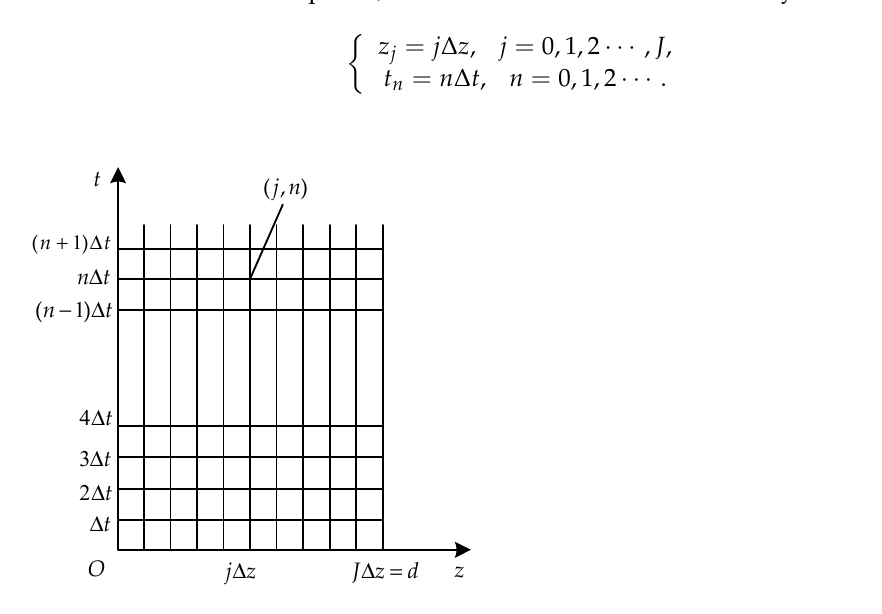
Figure 6. Solution domain of space-time discretization.